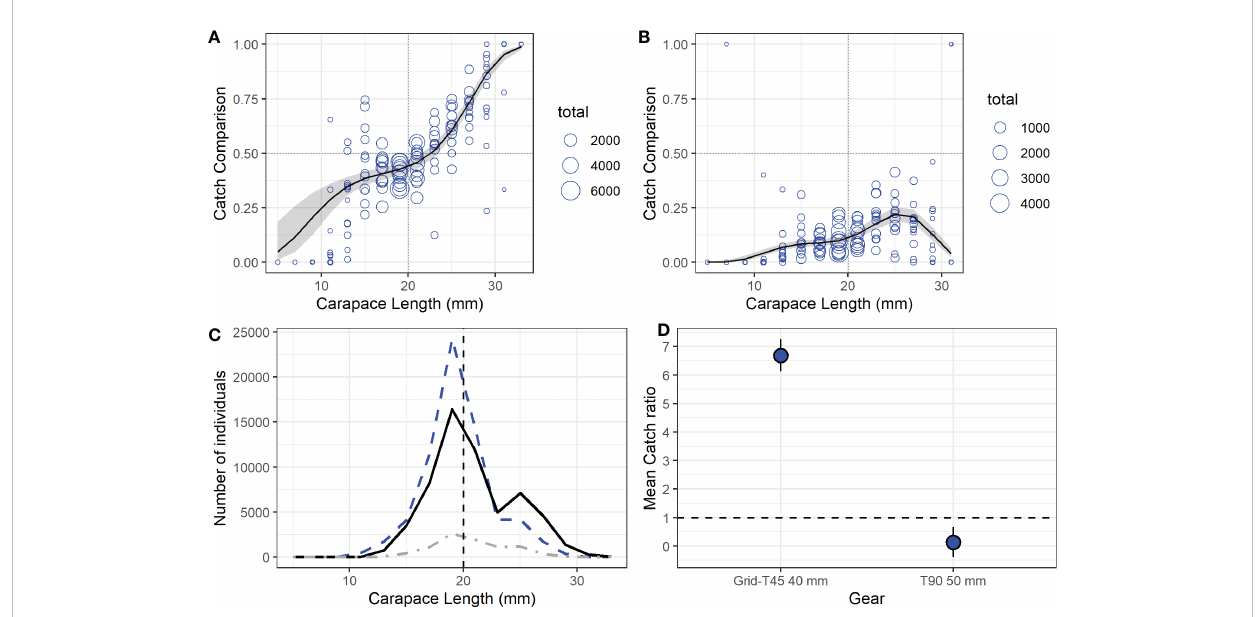
FIGURE 5 (A) Catch comparison curves for DPS caught with the Grid-T45 40 mm, and (B) with the T90 50 mm codend. Blue circles show observed proportions by haul, black dashed lines represent the model prediction, and the grey band indicates the 95% con fi dence limit. The level of no effect (CC( l ) = 0.5) is shown by horizontal black dashed lines while the MCRS is shown by the black vertical dashed lines. (C) Length frequency distributions of DPS caught during the campaign. The blue dashed line represents the control, the continuous black line represents the Grid-T45 40 mm, and the dark grey line represents the T90 50 mm codend. Black vertical dashed lines depict the MCRS according to the Reg. EU 1241/2019. (D) The blue dots indicate the mean catch ratio (CR( l )), and horizontal bars indicate the 95% con fi dence limit. The level of no effect (CR( l) = 1.0) is depicted by horizontal black dashed